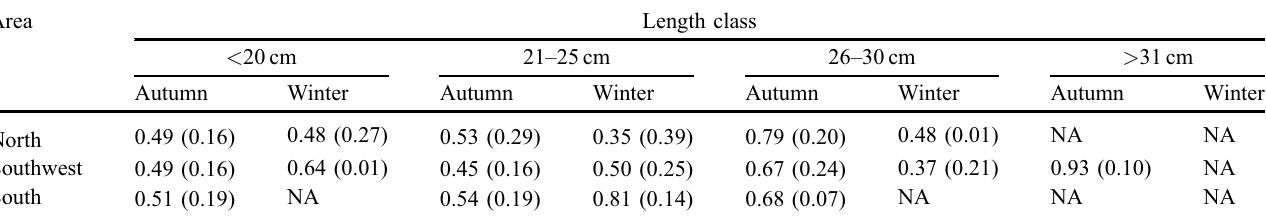
Table 1. Mean proportion of blue whiting females (standard deviation in brackets) by length class (cm) by survey season and study area on the Portuguese shelf. NA – not available.